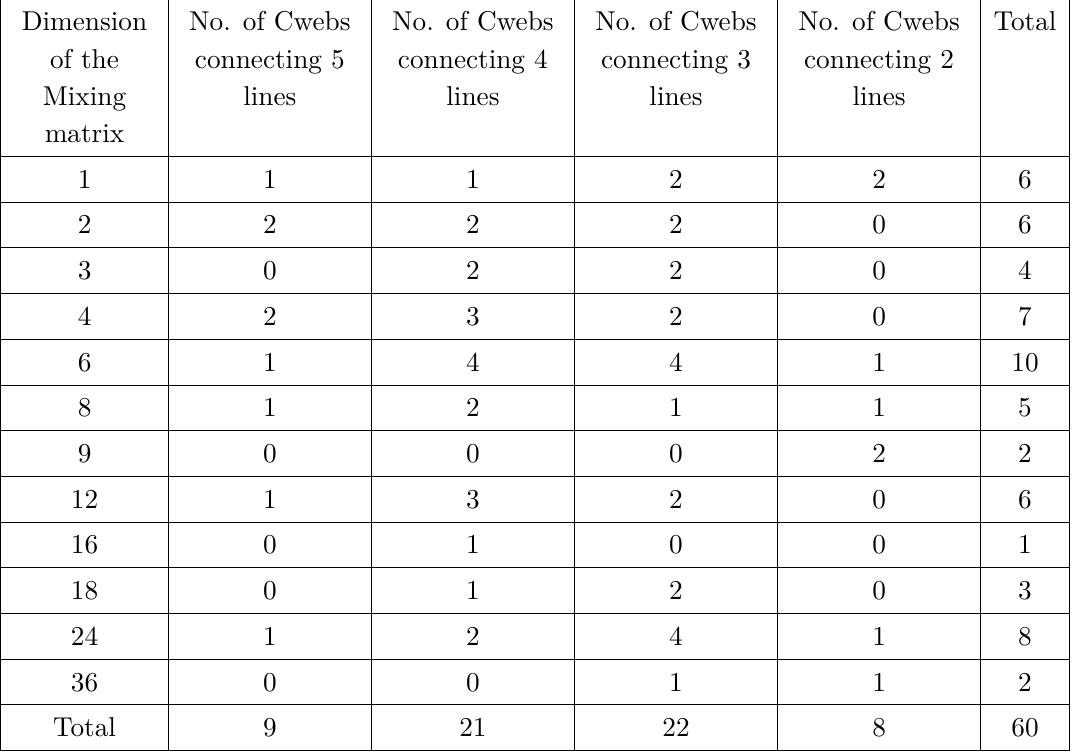
Table 1. Distribution of four-loop Cwebs according to the dimension of their mixing matrices and the number of their Wilson